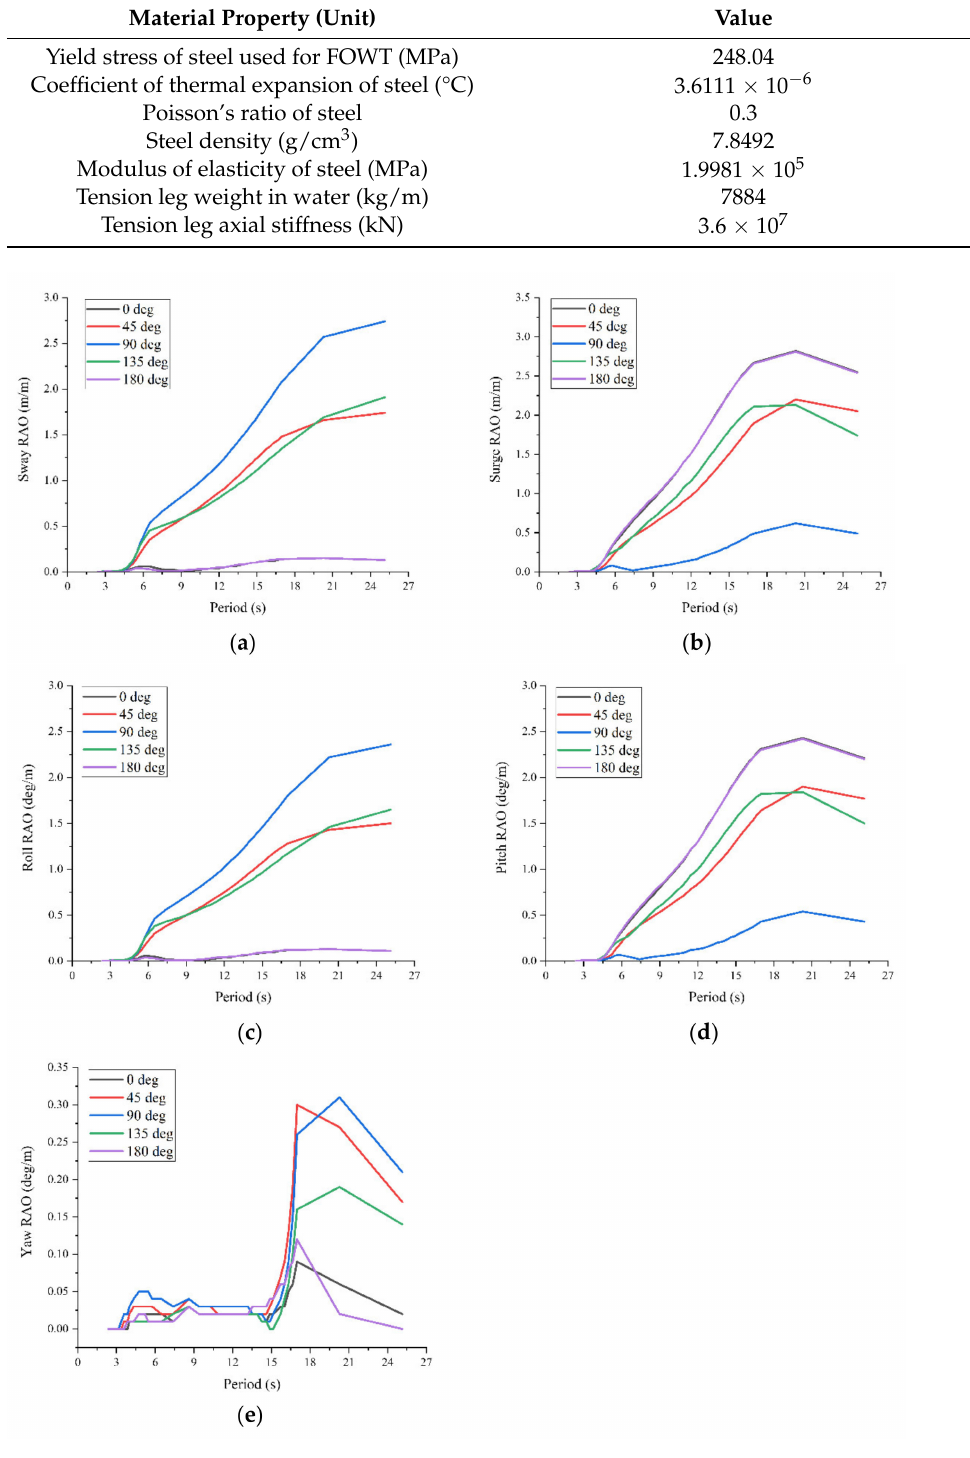
Figure 4. RAO for each degree of freedom: ( a ) Sway RAO, ( b ) Surge RAO, ( c ) Roll RAO, ( d ) Pitch RAO, and ( e ) Yaw